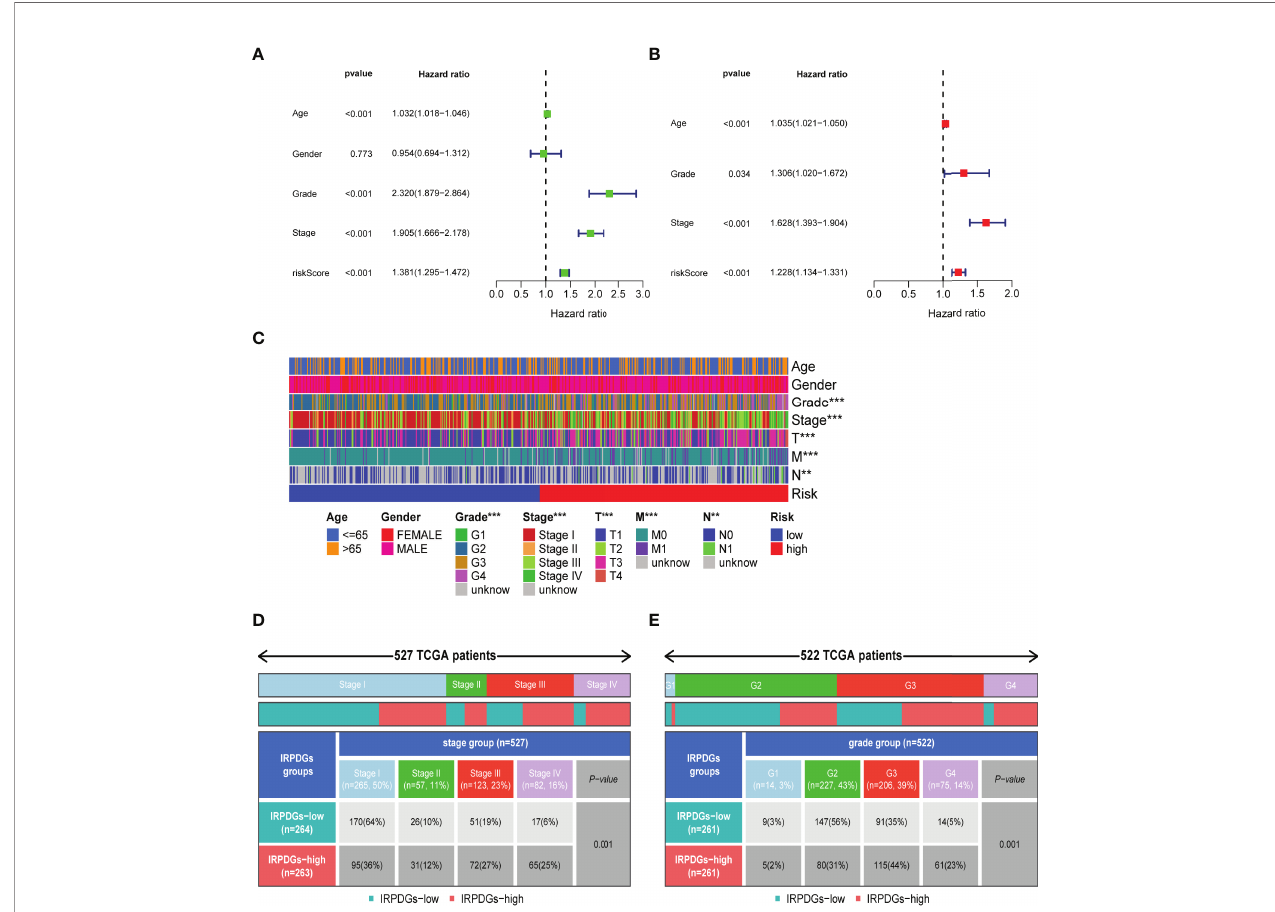
FIGURE 4 | Differences in clinicopathological information and prognostic assessment in different IRPDGs subgroups. (A) Univariate Cox analysis of clinicopathological factors and IRPDGs (P < 0.05). (B) Multivariate Cox analysis of clinicopathological factors and IRPDGs (P < 0.05). (C) Distribution of clinicopathological features in the subgroups of IRPDGs in the TCGA cohort (** P < 0.01, *** P < 0.001). (D) Differential tumor stages in the IRPDGs subgroup of the TCGA cohort. (E) Differential tumor grades in the IRPDGs subgroup of the TCGA